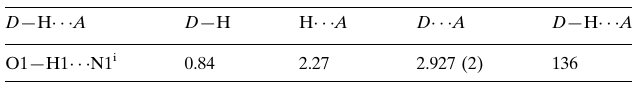
Hydrogen-bond geometry (A˚ , (cid:1)